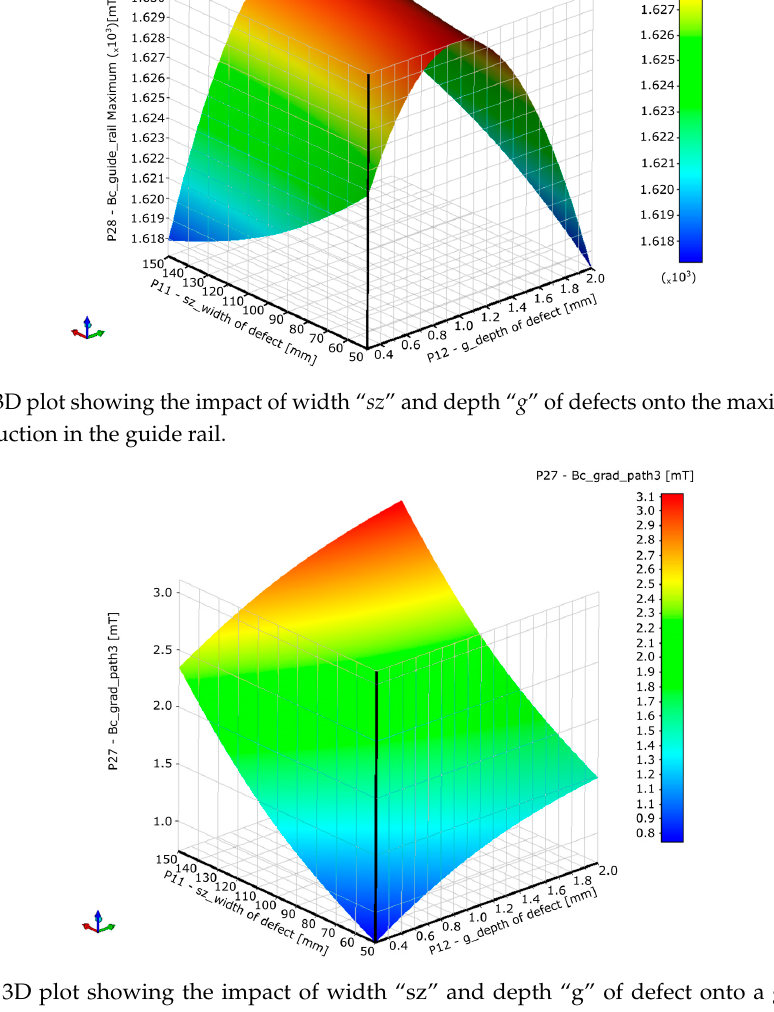
Figure 12. Form of detection line (called “path”). The values being maximum and minimum ones are selected from the data collected along the detection path from 200 test points, and the gradient of these values is computed. Figure 11 presents the impact of the defect dimensions g and sz onto the value of the gradient from the detection path.